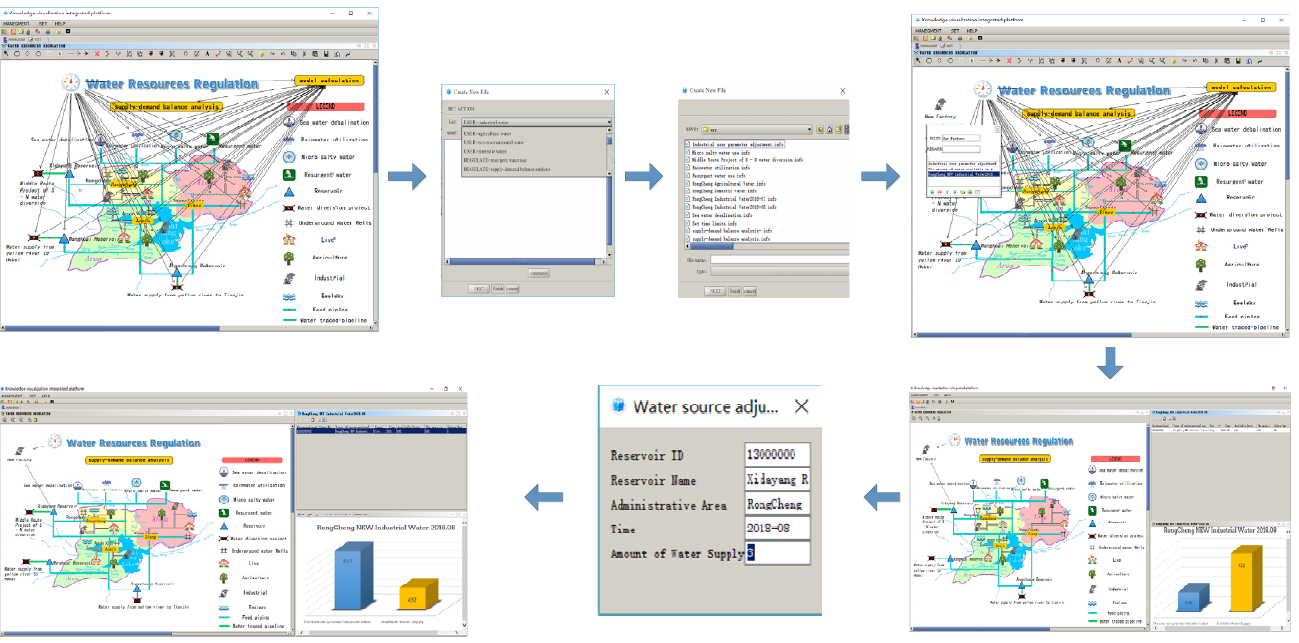
Figure 11. Example of dynamic regulation of water resources under the situation of increasing water users.